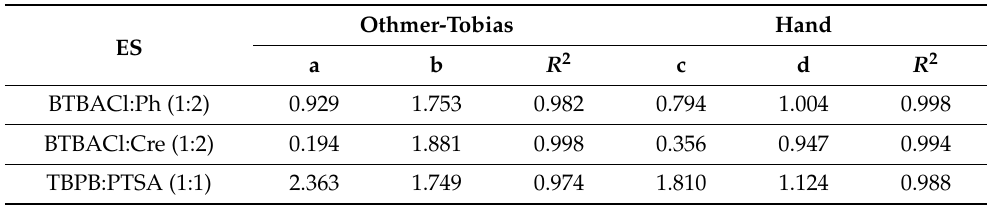
Table 2. Parameters of Othmer-Tobias and Hand correlation for ternary systems [benzene + cyclohex-